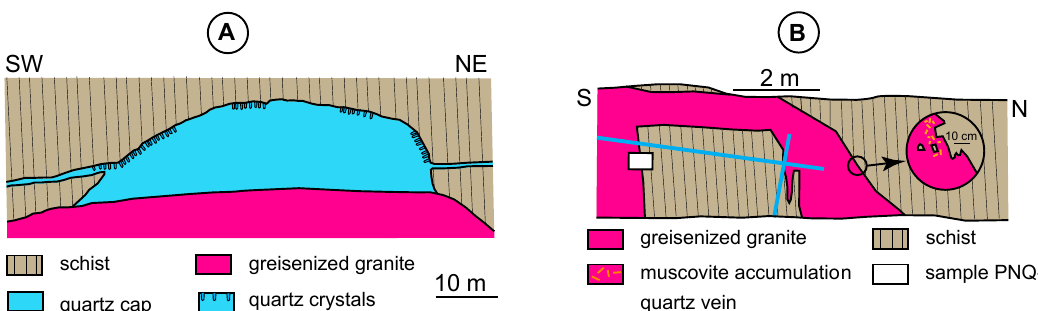
Figure 3. Details of the greisen cupola. ( A ) Quartz cap at the top of the greisen cupola (redrawn and interpreted from [11]). The big quartz crystals are inferred from the original description of [11], having not been drawn by them. ( B ) Sketch of the (greisenised) G4 granite intrusive contact at the L2 level (observations at the L2 level-2018).